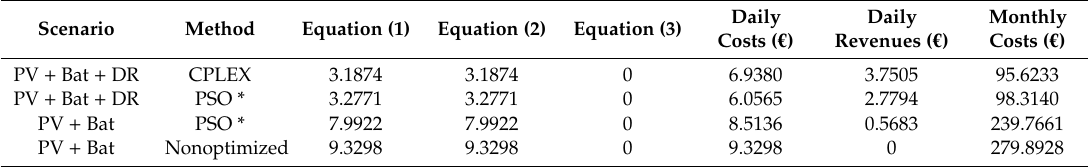
Table 5. Summary of